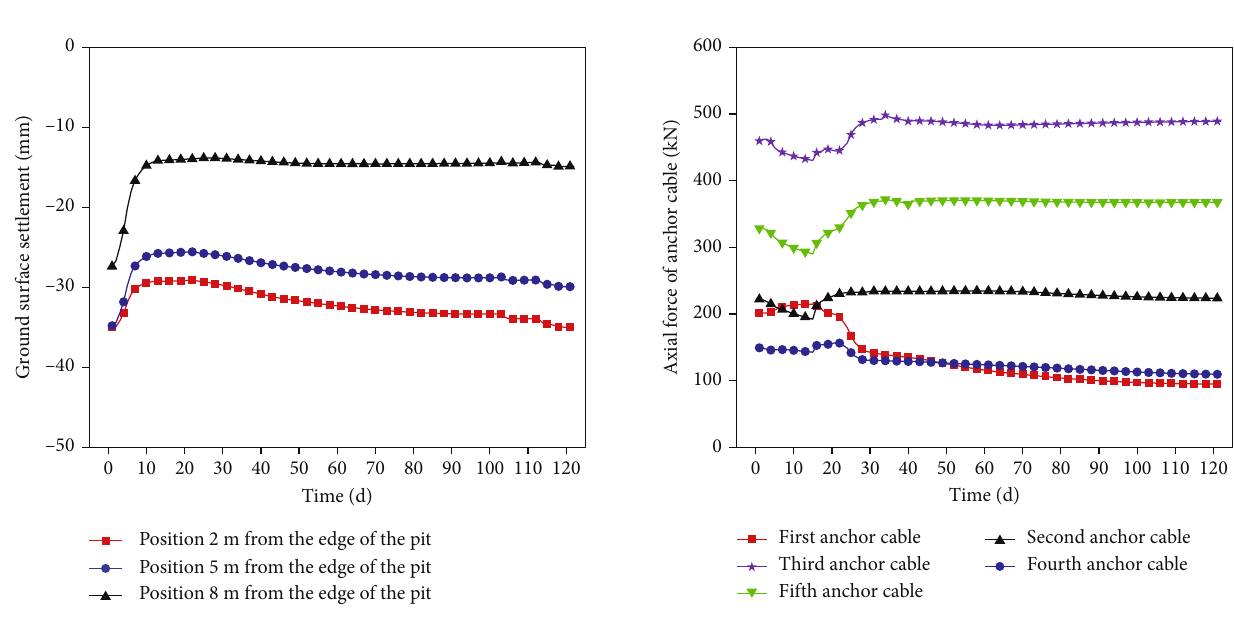
Figure 7: Variation in surface subsidence during spring thaw. Figure 8: Changes in the axial force of the prestressed anchor cables during spring